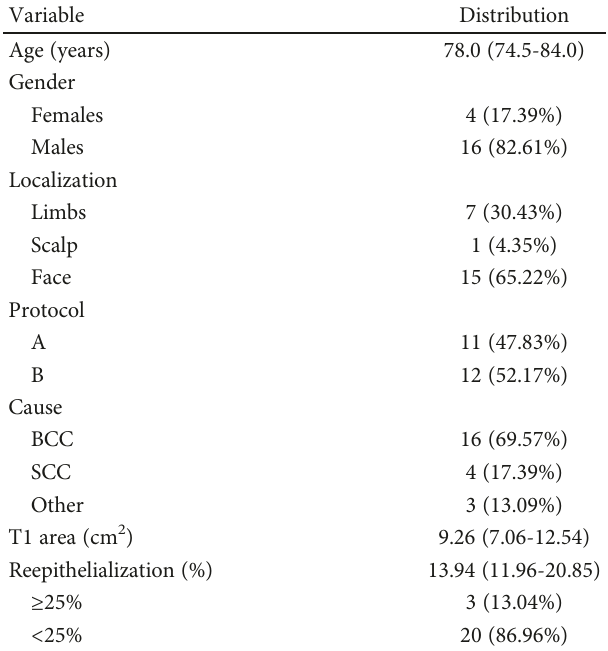
Table 1: Cohort ’ s characteristics. Categorical variables ’ distribution is described by counts and relative frequencies (%); continuous variables ’ distribution by median (25 th – 75 th